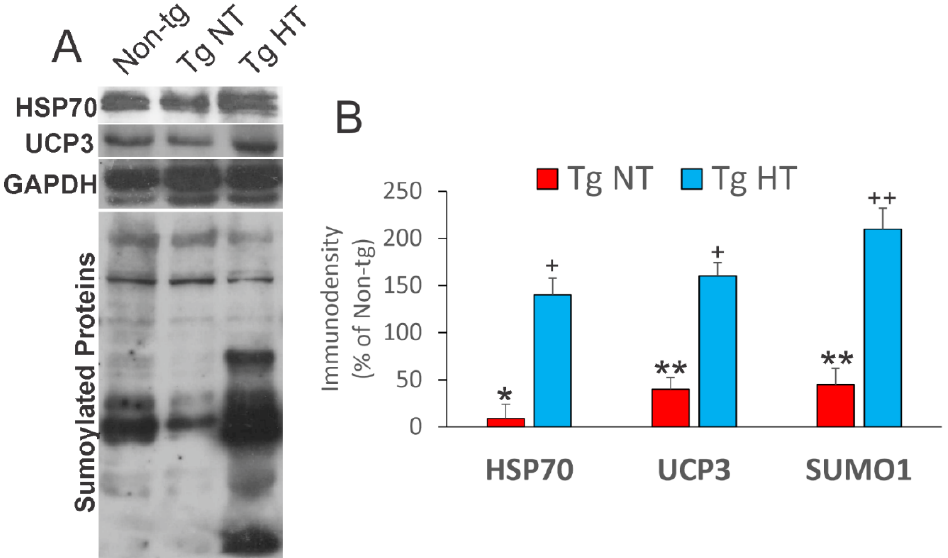
Figure 5. Whole-body cooling induced changes in cytoprotective proteins in the skeletal muscle of hSOD1-G93A tg mice at 12 weeks of age. ( A ) Representative Western blots for heat shock protein 70 (HSP70), uncoupling protein 3 (UCP3), and protein sumoylation (SUMO1) in hindleg muscle of non-tg mice (non-tg) and hSOD1-G93A tg mice that were cooled (Tg HT) or not cooled (Tg NT). GAPDH was used as a protein loading control. ( B ) Graph of quantitative analysis of target protein immunodensities. In NT hSOD1-G93A tg mice, HSP70 (* p < 0.001), UCP3 (** p < 0.01), and SUMO1 conjugated proteins (** p < 0.01) were significantly reduced compared to non-tg mice. In HT hSOD1-G93A tg mice, the levels of immunoreactivity for HSP70, UCP3, and SUMO-conjugated proteins were restored to non-tg levels or significantly exceeded non-tg levels (+ p < 0.05, ++ p < 0.01).